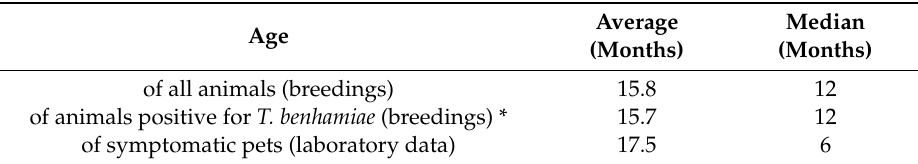
Table 3. Age distribution among the sampled animals. Age Average ( Months ) Median ( Months )